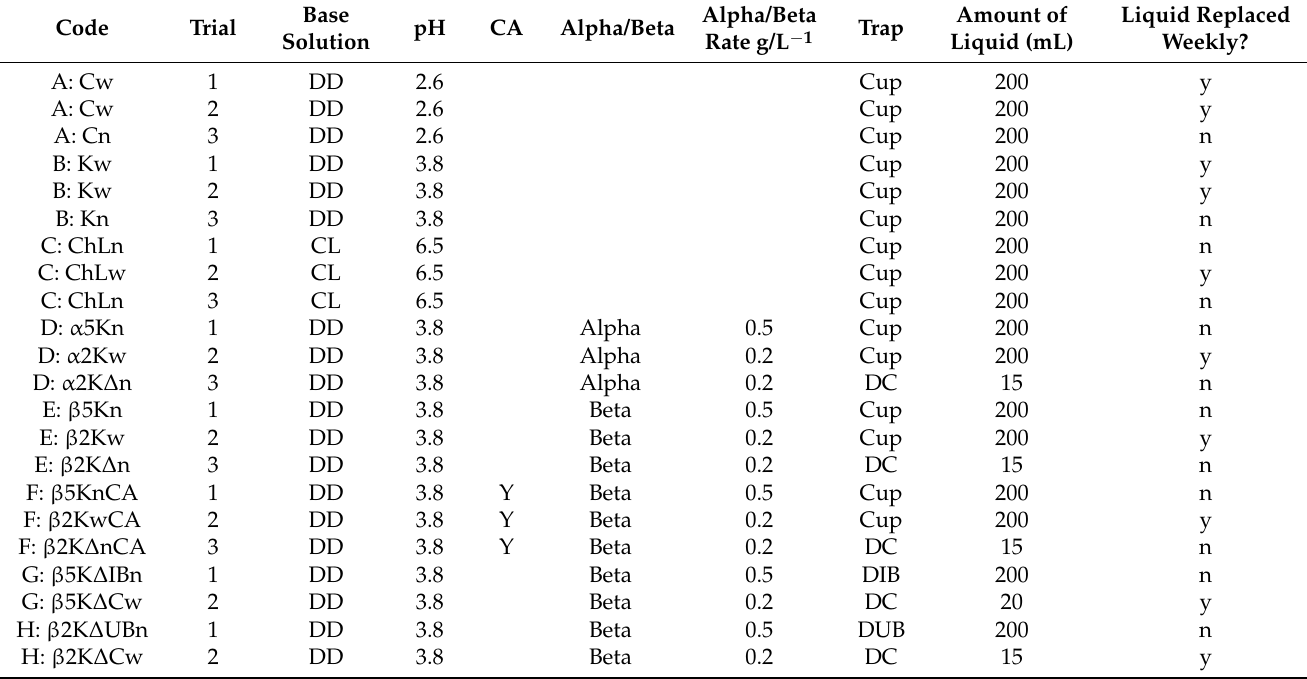
Table 1. Trap type and composition of liquid added for three trials, with eight or six treatments per trial. Base solution: DD: Droskidrink + soap; CL: Cha-Landolt solution; pH: KOH added to adjust pH to 3.8. CA—Citric acid (1 g L − 1 ). Trap: Cup—Red cup with a white lid; DC—Delta trap with a cup without a lid, with two cotton balls; DIB—Delta trap with an insulated bottle; DUB—Delta trap with the uninsulated bottle; y—Trap replaced weekly; n—not replaced weekly. Codes were created for better separation of treatments in